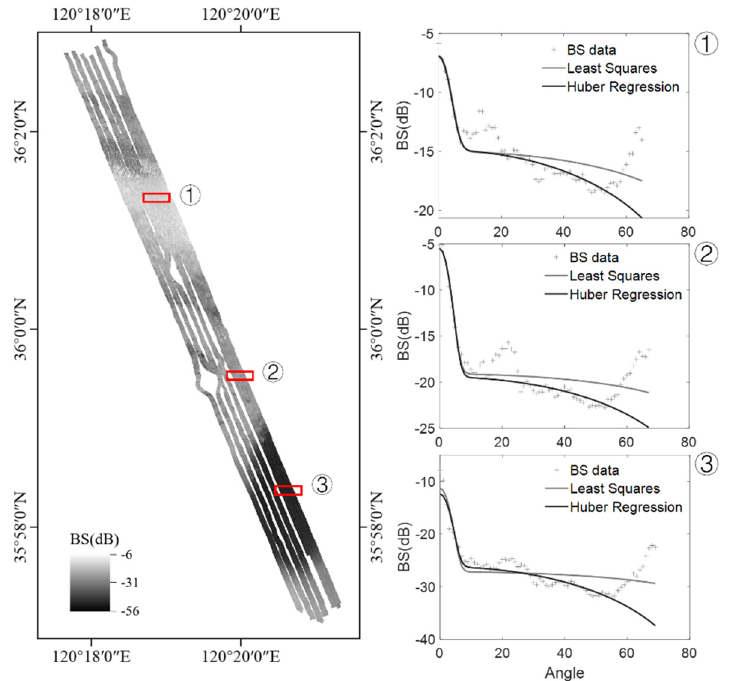
Figure 7. Comparison of ARC fitting results between least squares method and Huber regression